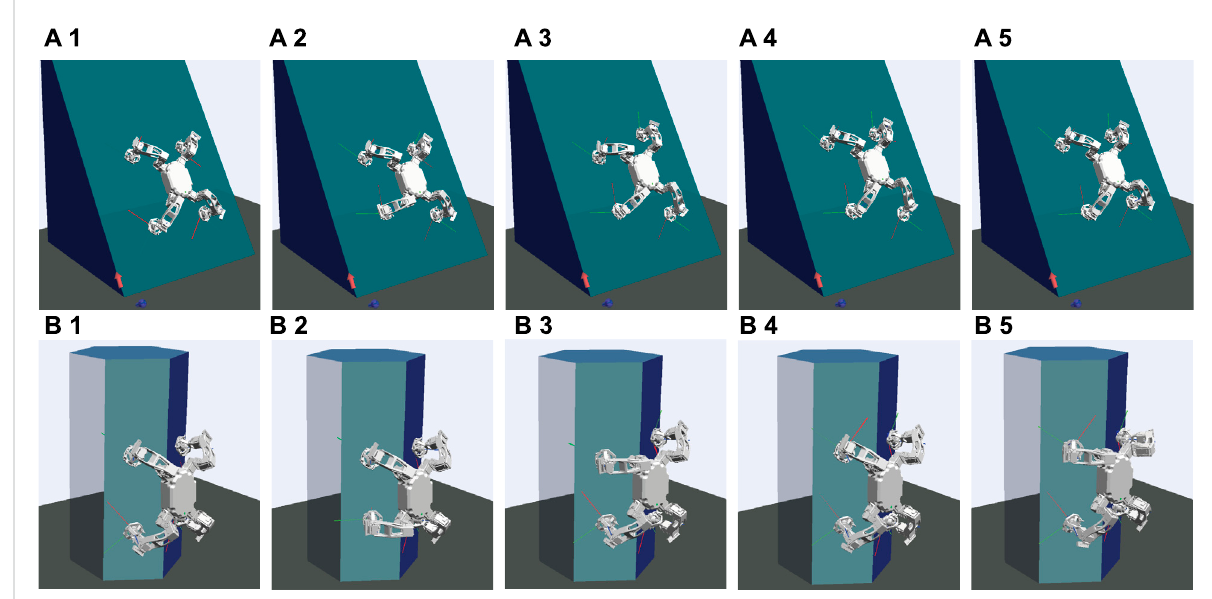
FIGURE 4 Multi-contactscenarioson (A) a fl atslopeat α =1radand (B) ahexagonalstructure.Arobotisclimbinguponeachstructurebymovingitsfeetin the order of left bottom (1 → 2), right top (2 → 3), left top (3 → 4), and right bottom (4 → 5).